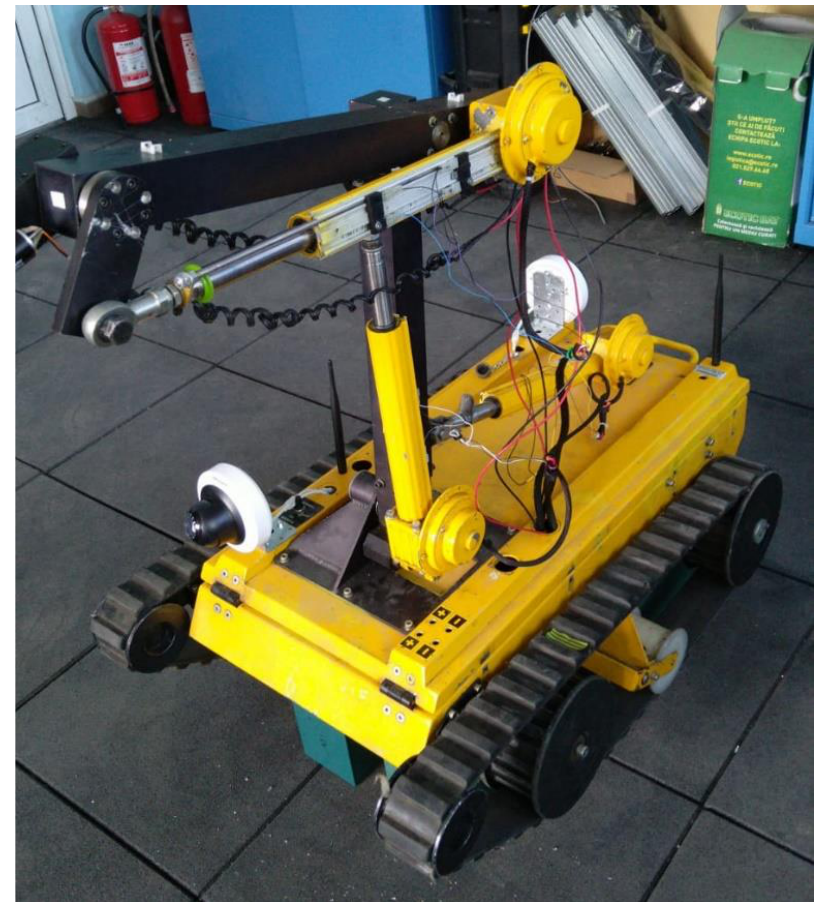
Figure 1. The analyzed EOD